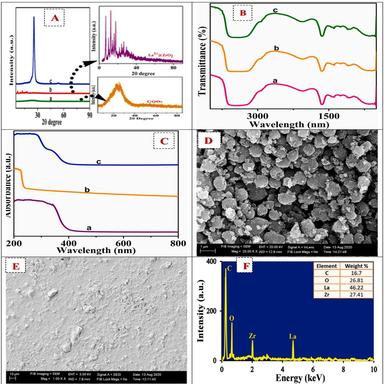
A) XRD pattern of GQDs (a), La3+@ZrO2 (b) and GQDs@La3+@ZrO2 (c); B) FT-IR spectra of GQDs (a), La3+@ZrO2 (b) and GQDs@La3+@ZrO2 (c); C) UV–Visible spectra of GQDs (a), La3+@ZrO2 (b) and GQDs@La3+@ZrO2; D) FE-SEM image of La3+@ZrO2; E) FE-SEM image of GQDs@La3+@ZrO2; F) EDX spectrum of GQDs@La3+@ZrO2.